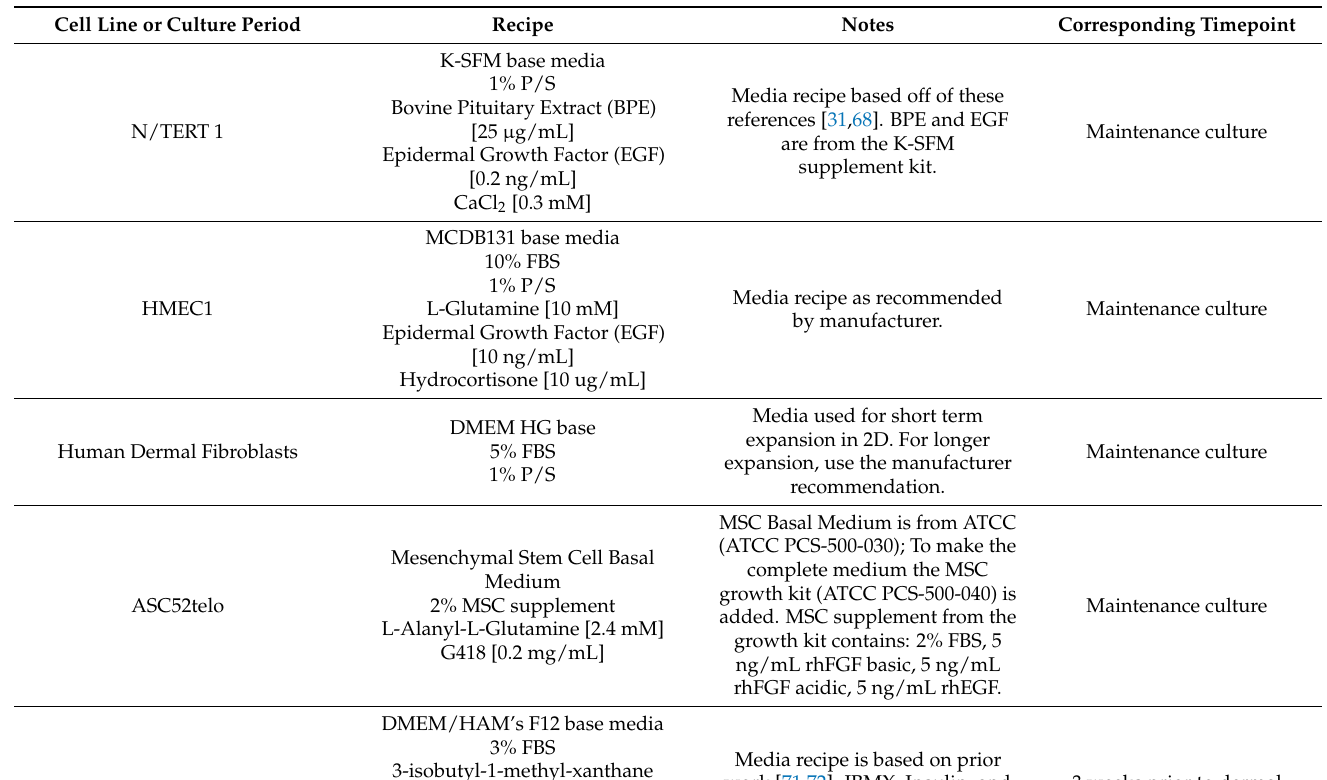
Table 1. Media used for 2D and 3D